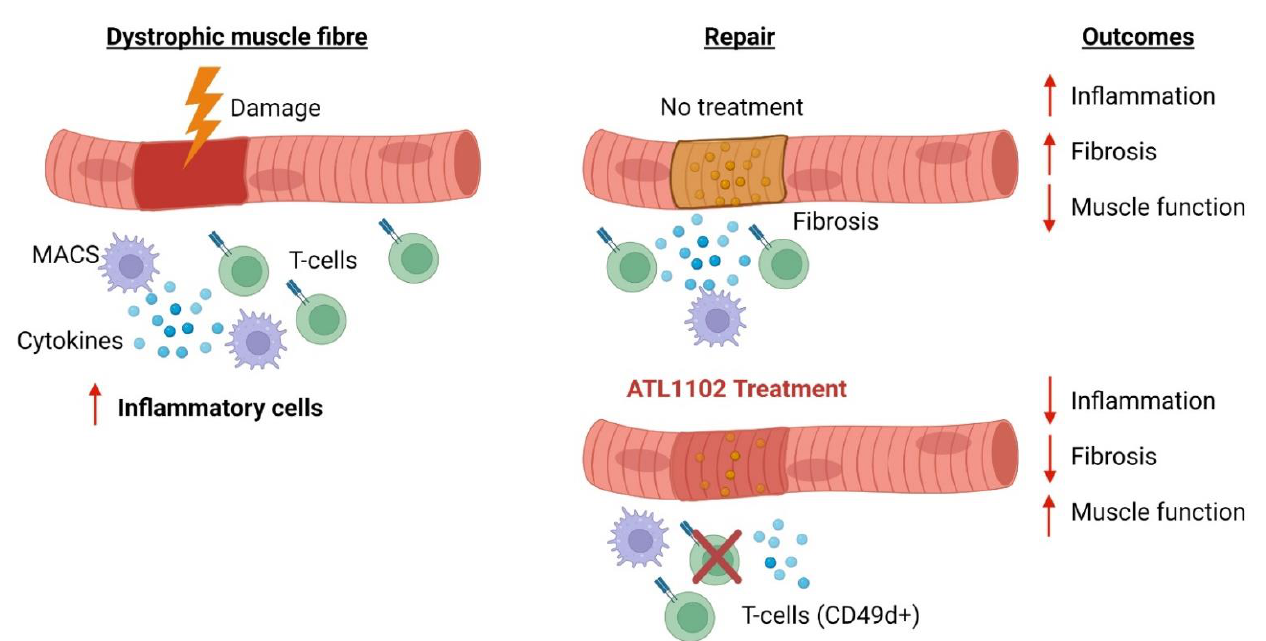
Figure 2. Using anti-sense oligos (ASO) to target T cells in dystrophic muscle. Repeated cycles of muscle damage in dystrophic muscle results in an influx of inflammatory cells and pro-inflammatory cytokines (MACS = macrophage, pro-inflammatory cytokines, and T-cells) leading to fibrosis and reduced muscle function. CD49d is a biomarker in DMD, with high levels of CD49d+ T-cells linked to poorer disease prognosis and earlier loss of ambulation [13]. ATL1102 is an anti-sense oligo (ASO) that has been developed to selectively target the RNA of human CD49d blocking its translation to dampen T cell response in dystrophic inflammation. We hypothesise reducing expression CD49d would result in dampening of inflammation to improve muscle regeneration, reduce fibrosis and improve muscle function.